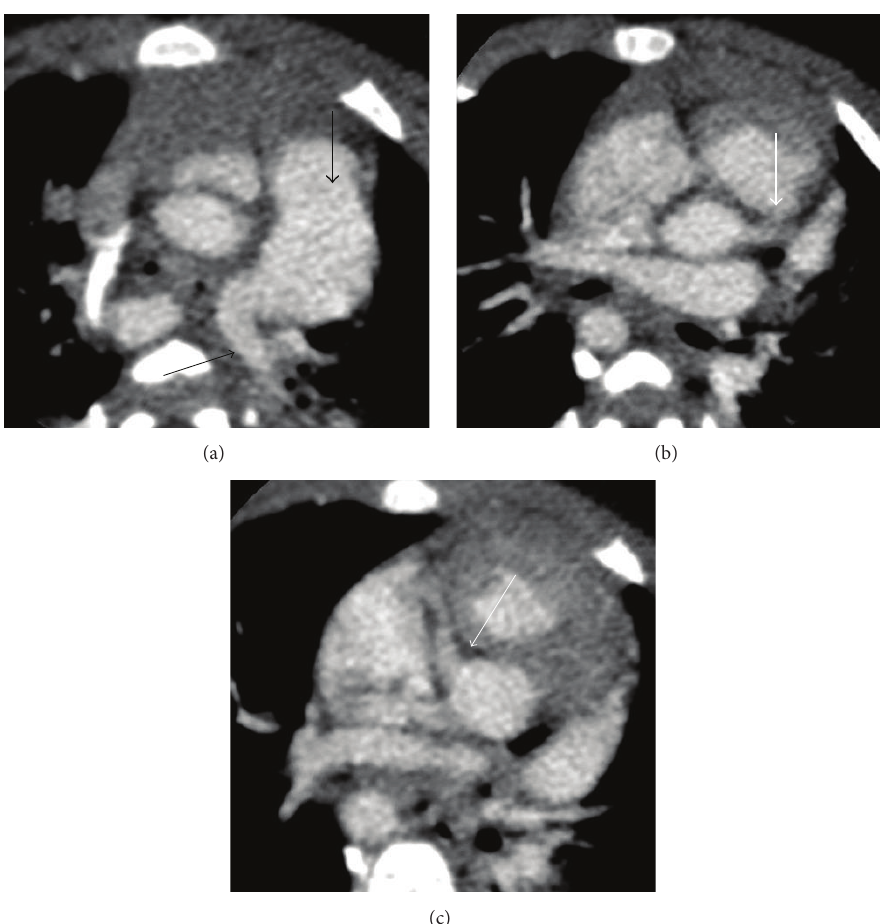
Figure 5: Multiple slices from a postcontrast CTA of the chest from superior to inferior demonstrate enlargement of the pulmonary artery (thick black arrow) and crisscross pattern of the pulmonary arteries (thin black arrow). There is dilatation of the origins of the left coronary artery (thick white arrow) and right coronary artery (thin white